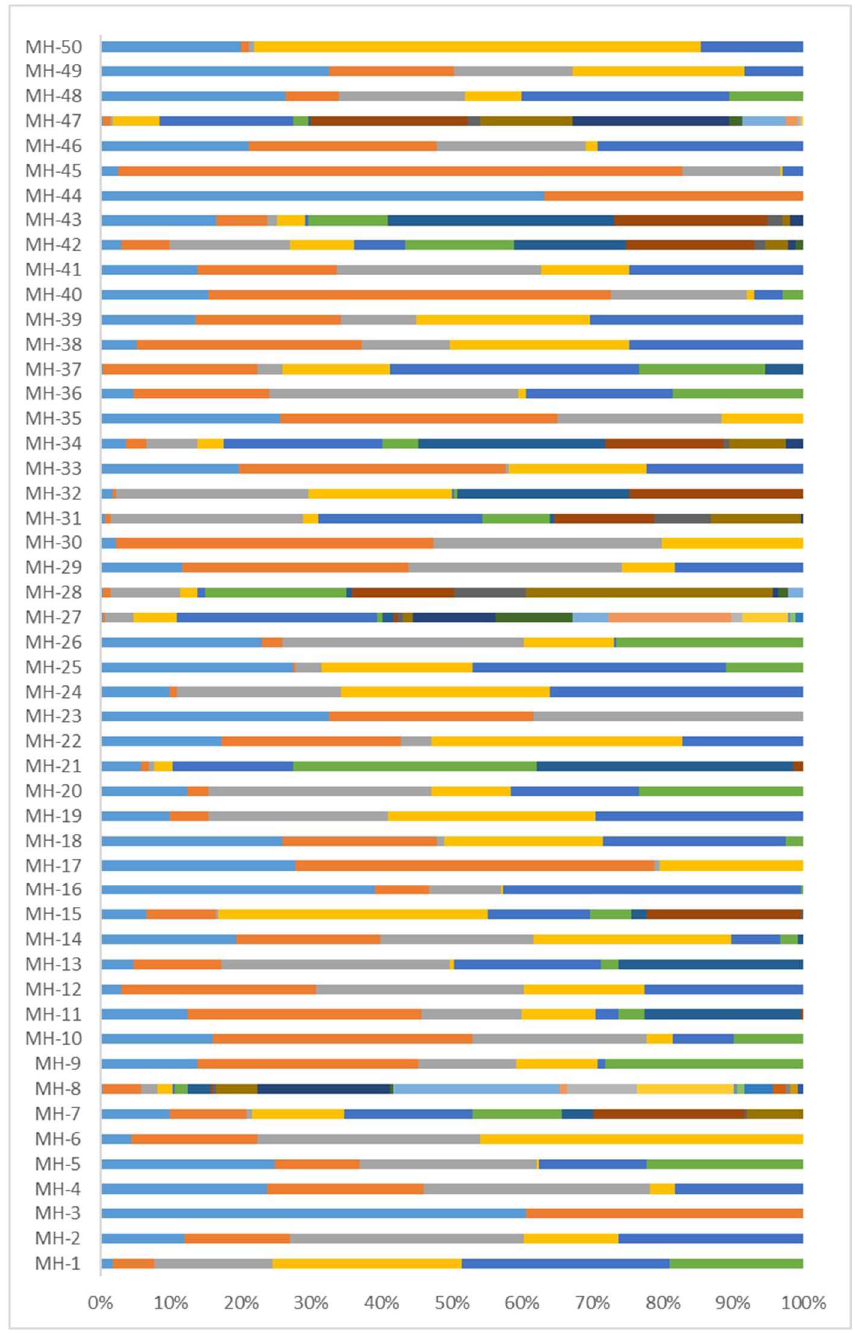
Figure 5. Allele frequencies of 50 MHs based on sequenced 137 Southwest Chinese Han unrelated individuals. Different colors of the bars represent different haplotypes (alleles), and the length of each bar represents the frequency of each allele.